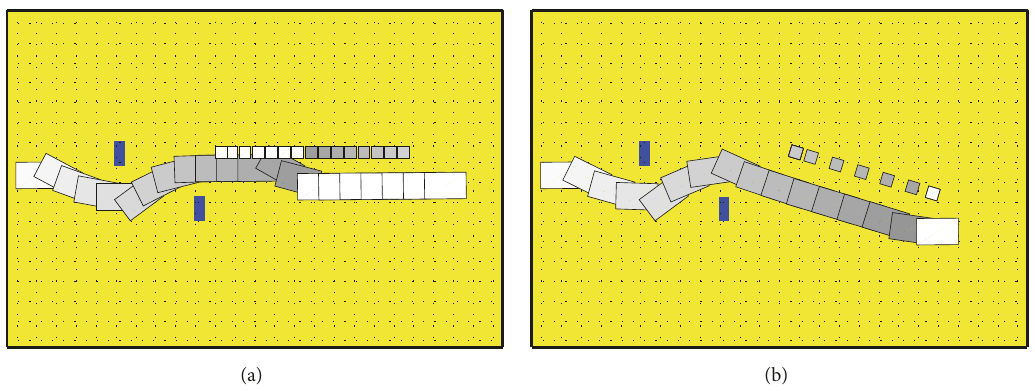
Figure 12: Simulation results under dynamic environments: (a) Scenario 1. (b) Scenario 2.